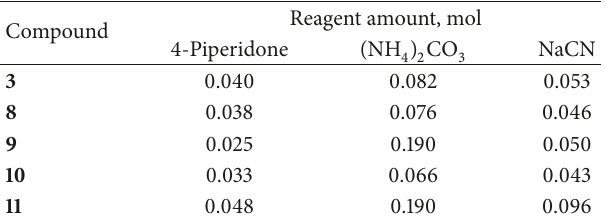
Table 1: The proportions of reagents used in the synthesis of 8- (2-ethoxyethyl-,3-ethoxypropyl-,3-butoxypropyl-)-6-( X ,